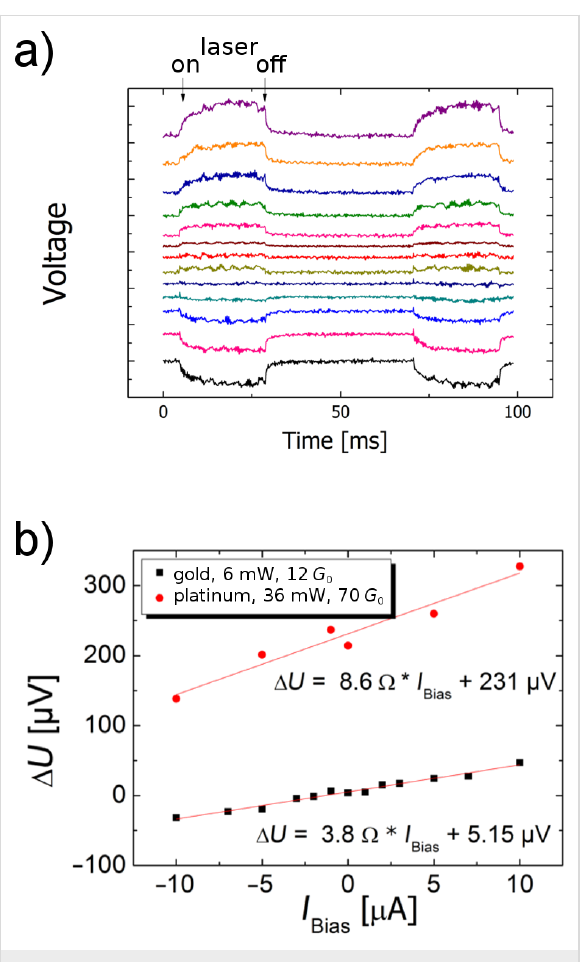
Figure 9: (a) Voltage change during the laser pulse at an Au–Ag–Au junction versus time for different bias currents from +10 µA to − 10 µA (red curve recorded at 0 µA). One division corresponds to 50 µV. The traces are offset vertically to avoid overlap. The incident laser power during the pulses was 15 mW. (b) Voltage change versus bias current for two different material combinations, Au–Ag and Pt–Ag.